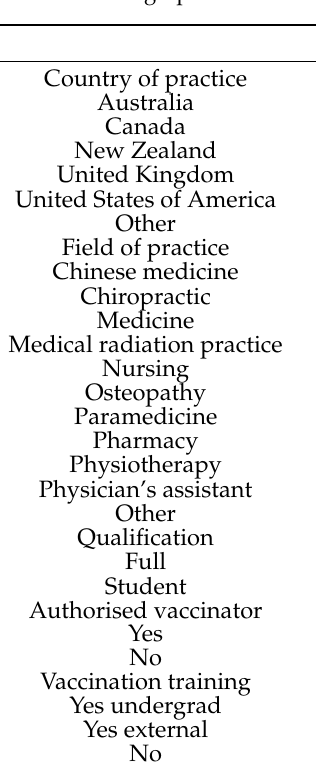
Table A1. Demographic data.